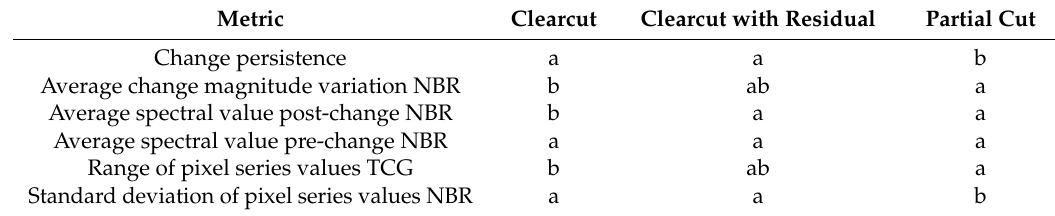
Homogenous groups per metric are identified using the same letter. NBR, Normalized Burn Ratio; TCG, tasseled cap greenness.